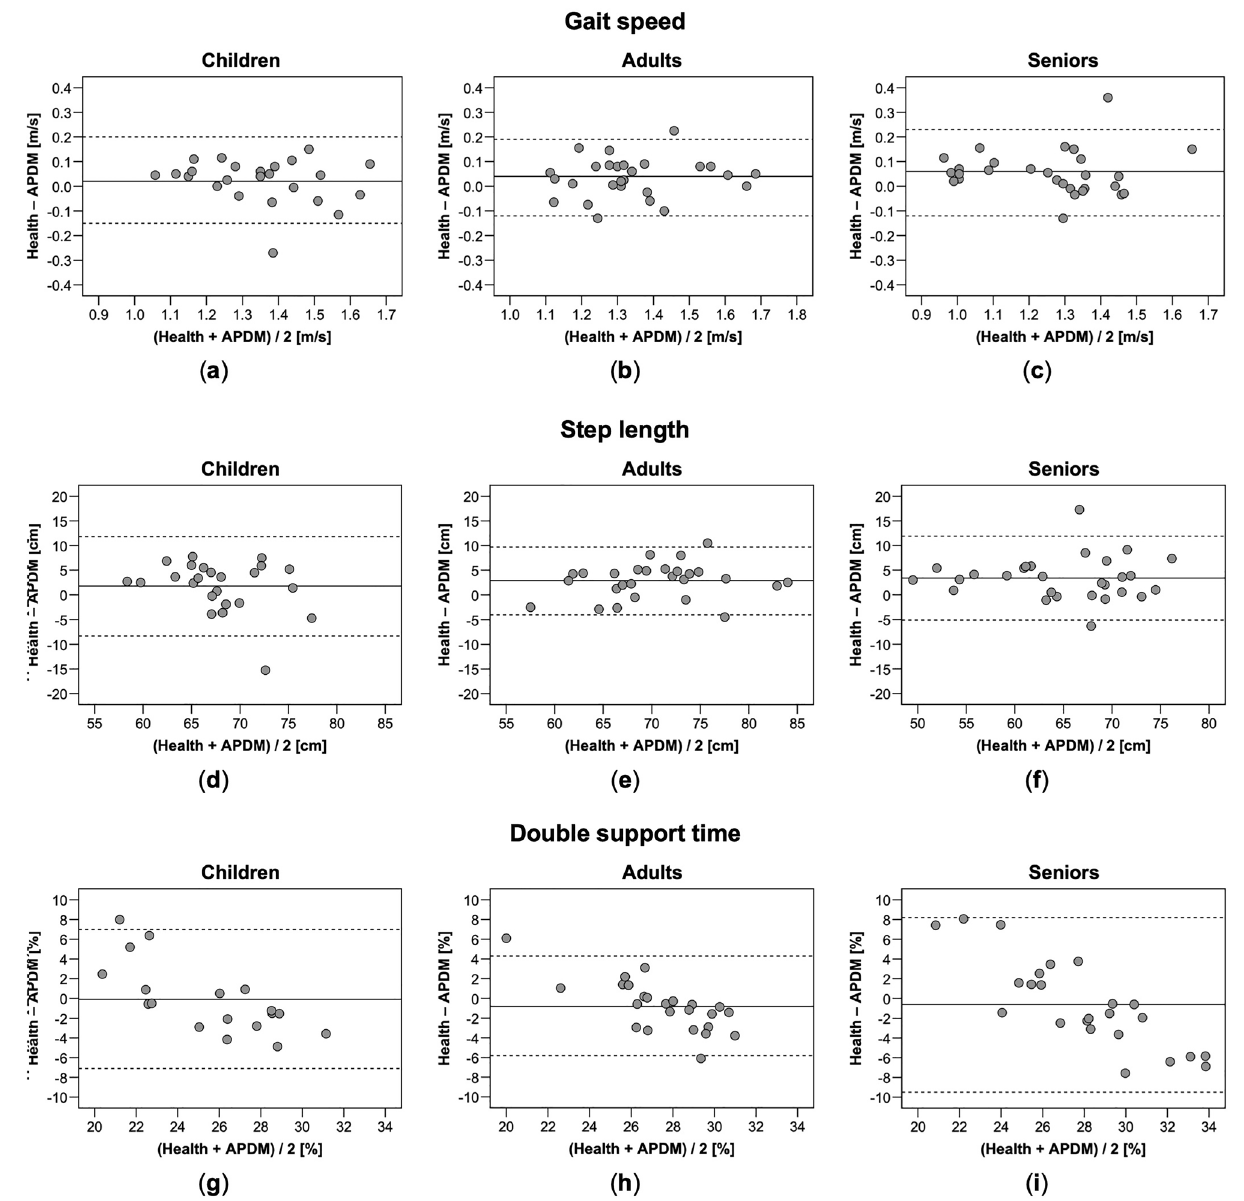
Figure 1. Bland–Altman plots for gait speed ( a – c ), step length ( d – f ) and double support time ( g – i ) measured with the Health app and the APDM Mobility Lab in children, adults, and seniors. Solid lines indicate mean between-method differences (bias) and dashed lines indicate upper and lower 95% limits of